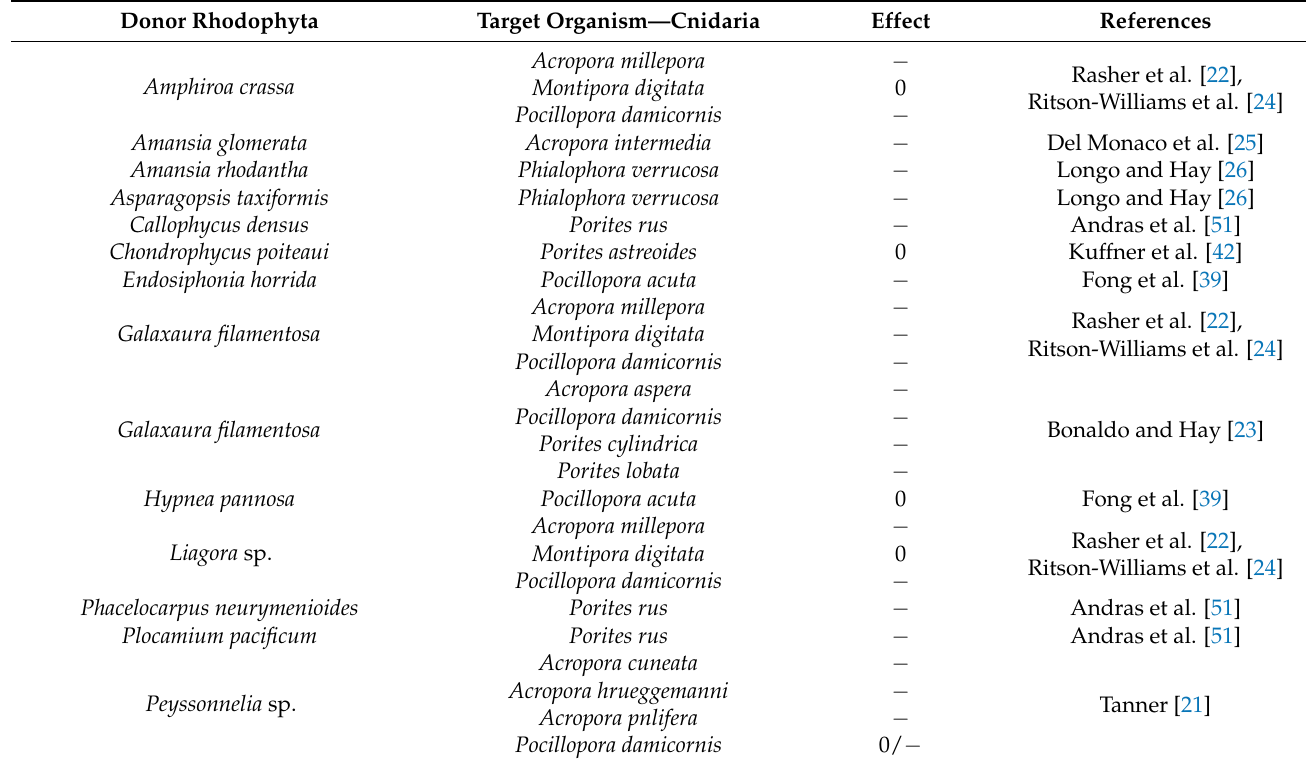
Table 2. Examples of allelopathic activity of red algae against competitors and